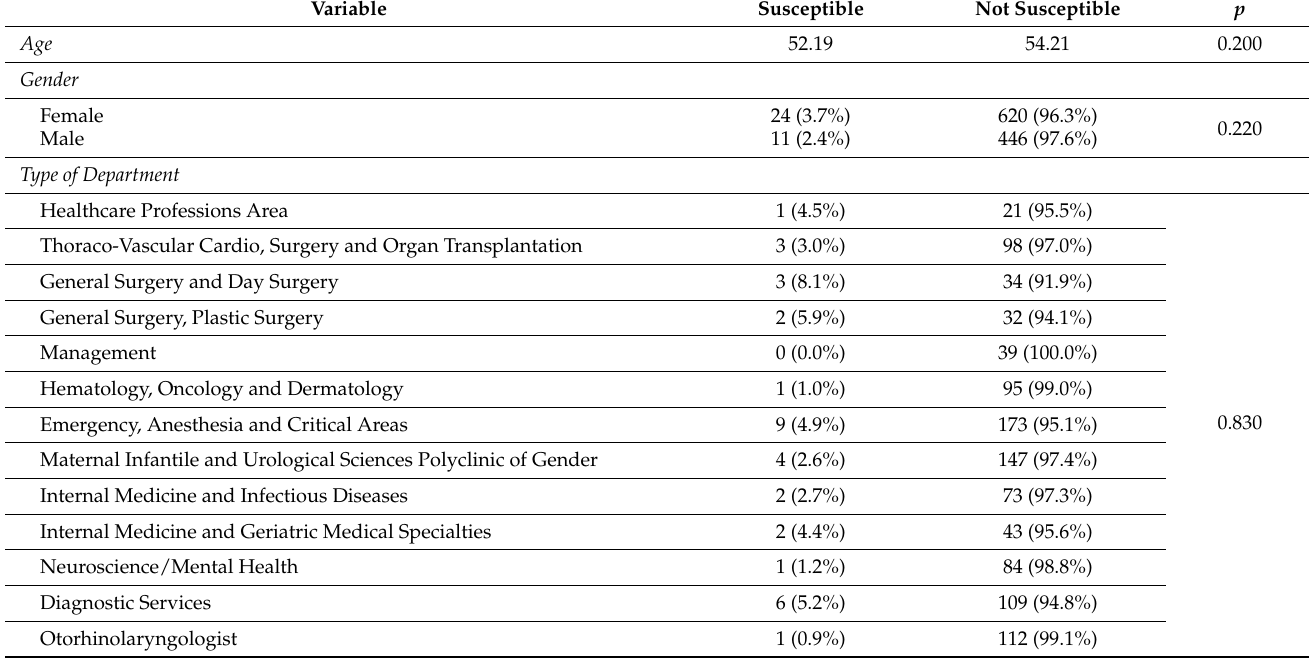
Table 3. Univariate analysis relating to chickenpox